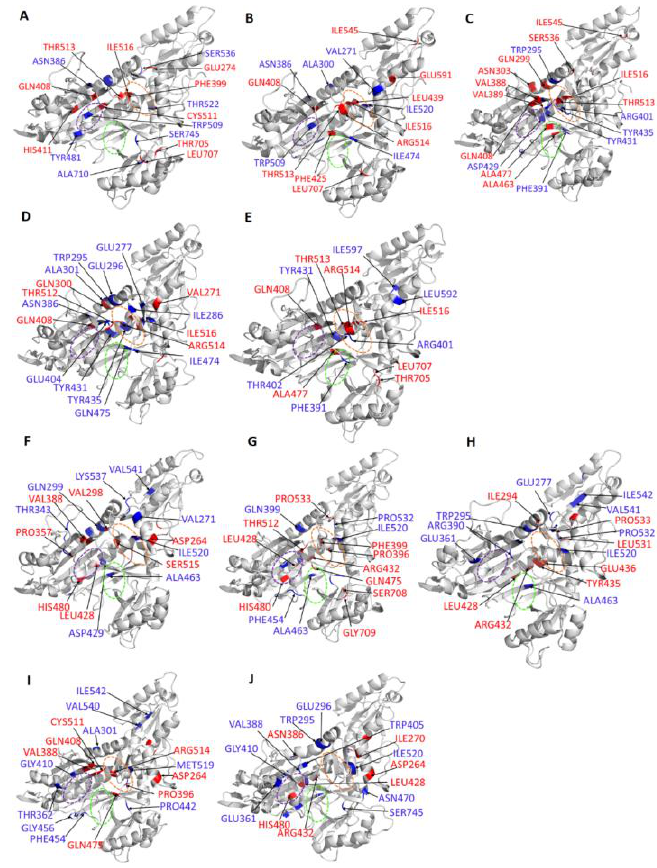
Figure 10. Cartoon representation of PfProRS homology model showing structural mapping of residues with significant ∆ BC (2 standard deviations). ∆ BC values were calculated by taking the BC value of the holo protein less the ligand-bound complex. Structures were obtained at 200 ns of the MD simulations. Residues with negative ∆ BC values are shown in blue while residues with positive ∆ BC values are shown in red. The active site is shown in green ellipses, ATP binding site in yellow ellipses and the predicted allosteric site in orange ellipses. ( A ) PfProRS-SANC152 complex, ( B ) PfProRS-SANC235 complex, ( C ) PfProRS-SANC236 complex, ( D ) PfProRS-SANC244 complex, ( E )